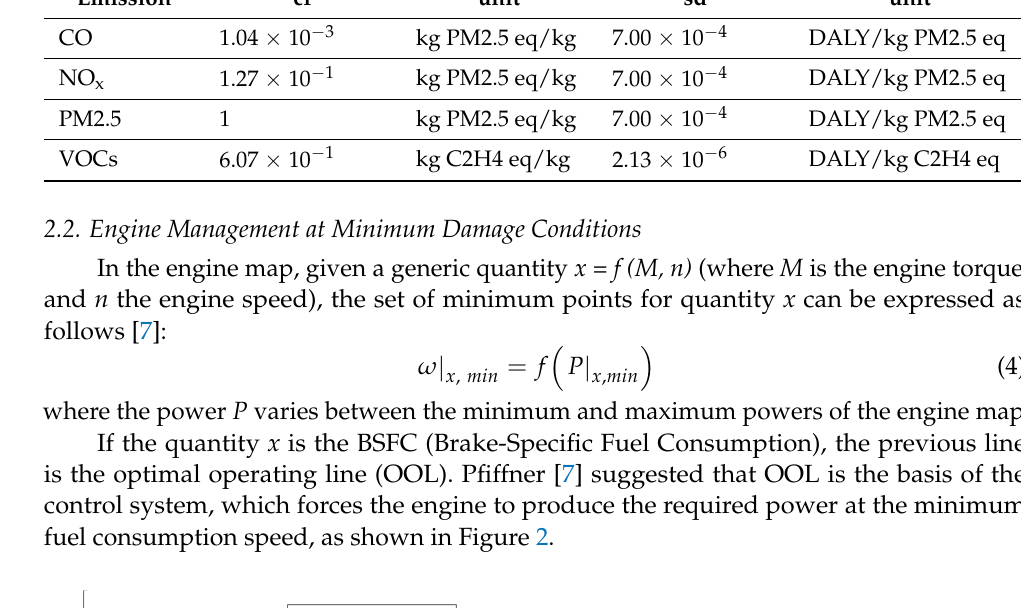
Table 1. Values of the coefficients for the damage calculation according to HIA [29]. Emission cf